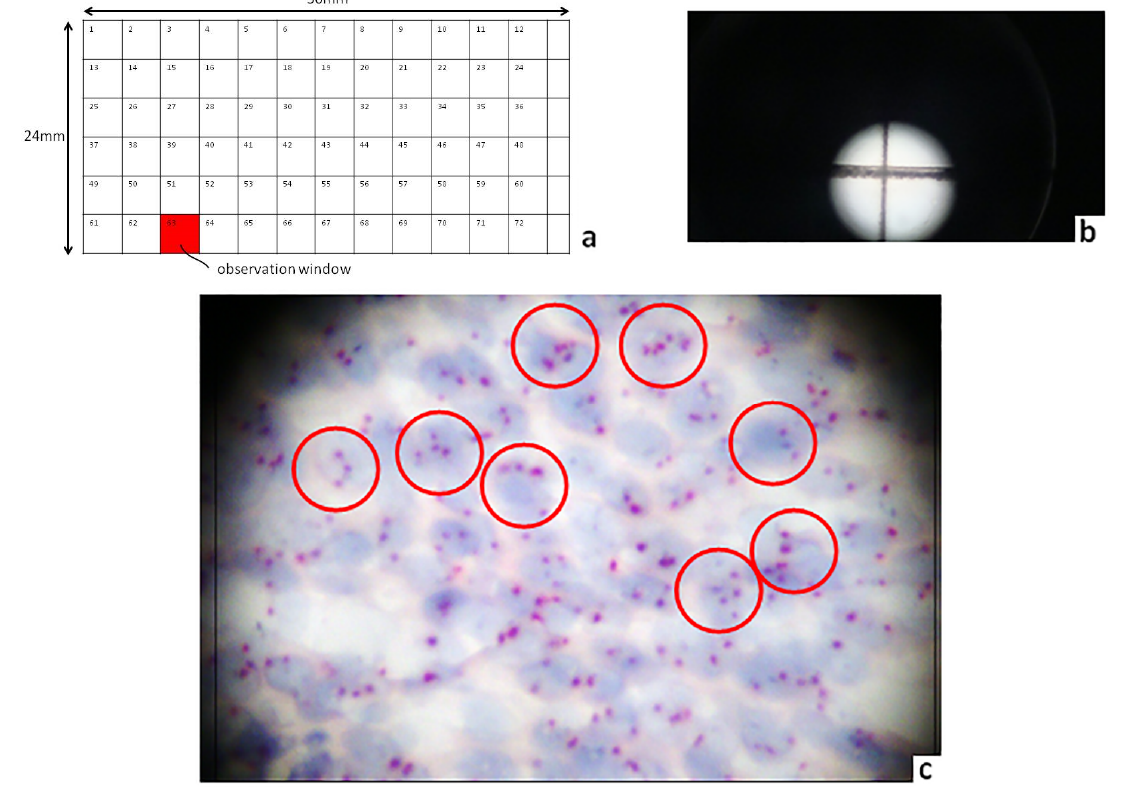
Figure 1. Chromosome 9 CISH analysis in OSCC. ( a ) Schematic presentation of the grid-based coverslip that was implemented in CISH slide screening mapping. Note this prototype grid consisting of seventy-two ( n = 72) rectangular square areas arranged in 12 columns and 6 rows. The square numbered 63 simply indicates characterically an individual observation window ( b ) A snapshot of the grid-based coverslip demonstrating a fine cross made by laser inscription that splits its surface into four square segments. ( c ) Chromosome 9 polysomy in a malignant tissue section. Note 3 to 5 isolated, light-brown centromeric signals per nucleus in a sub-group of the stained nuclei (inside red circles DAB chromogen; original magnification 400×).